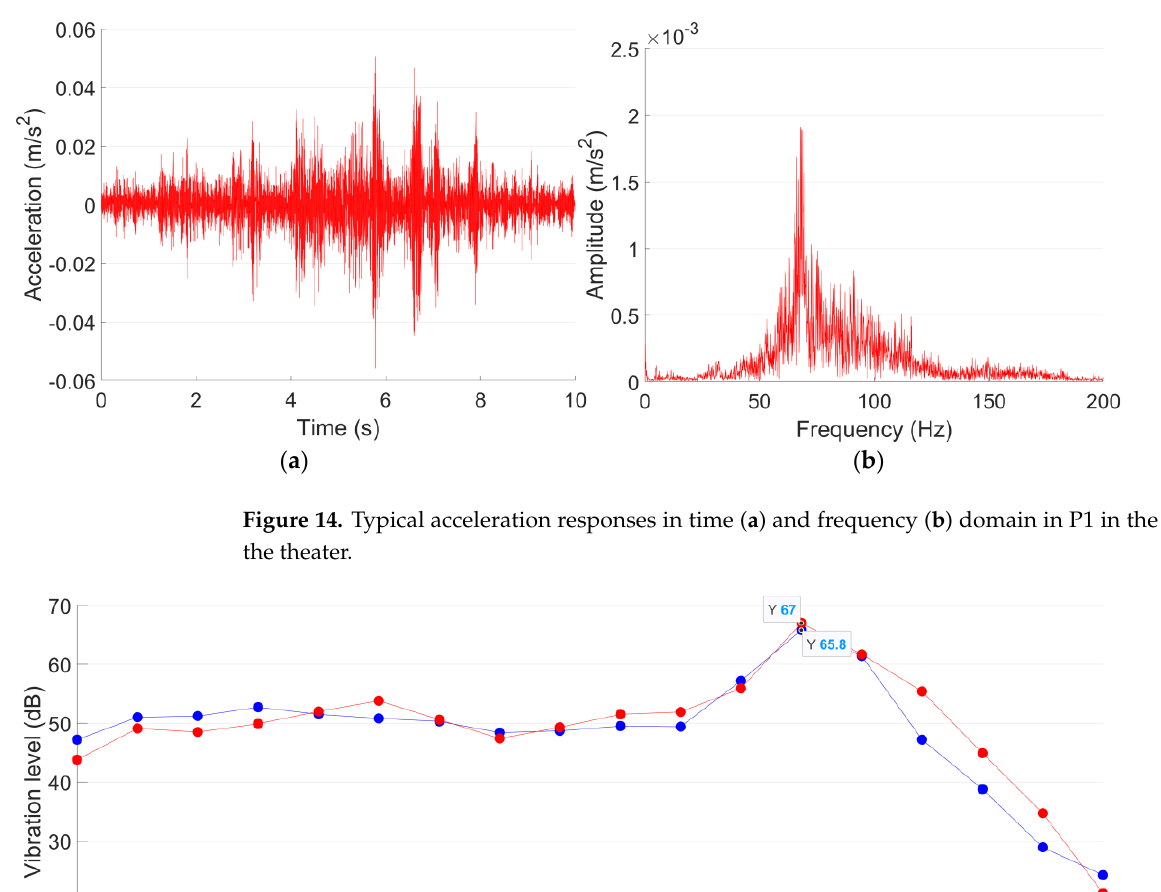
Figure 13. Typical acceleration responses in time ( a ) and frequency ( b ) domain in 1F test point in the shopping center.